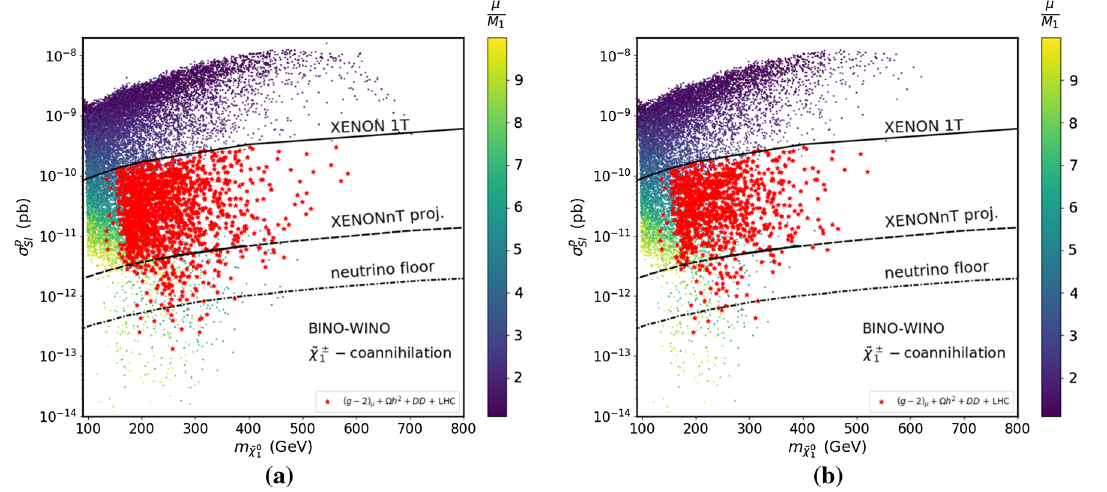
Fig. 12 Scan results in the m ˜ χ 0 the black lines indicates the DD limits (see text). In red we show the – σ SI p plane for bino-wino ˜ χ ± - 1 1 points fulfilling ( g − 2 ) μ , the relic density, DD and the LHC constraints coannihilation scenario for current (left) and anticipated future limits (right) from ( g − 2 ) μ . The color coding of the points denotes μ/ M 1 and